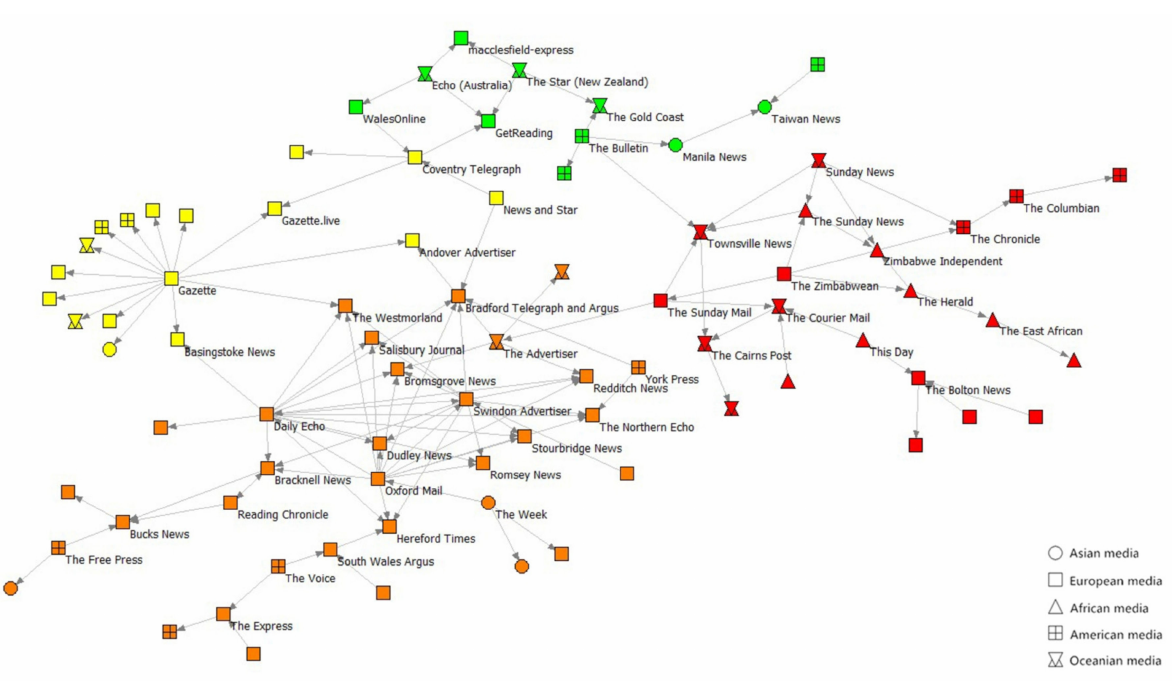
Figure 11. The main component of the edge of